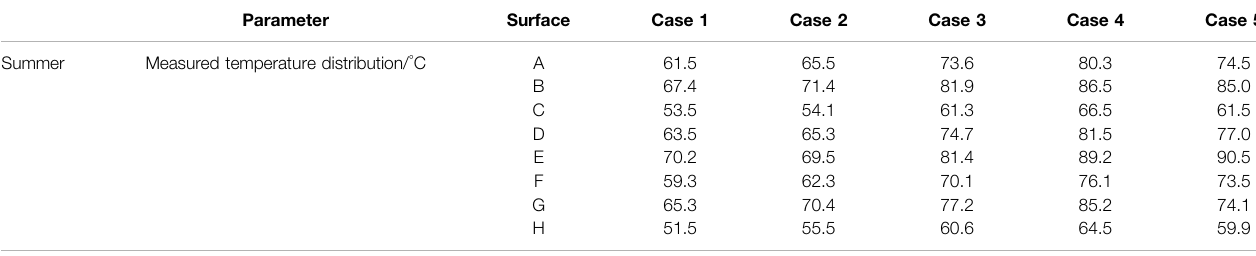
TABLE 4 | Each surface temperature at different inlet temperatures in summer.